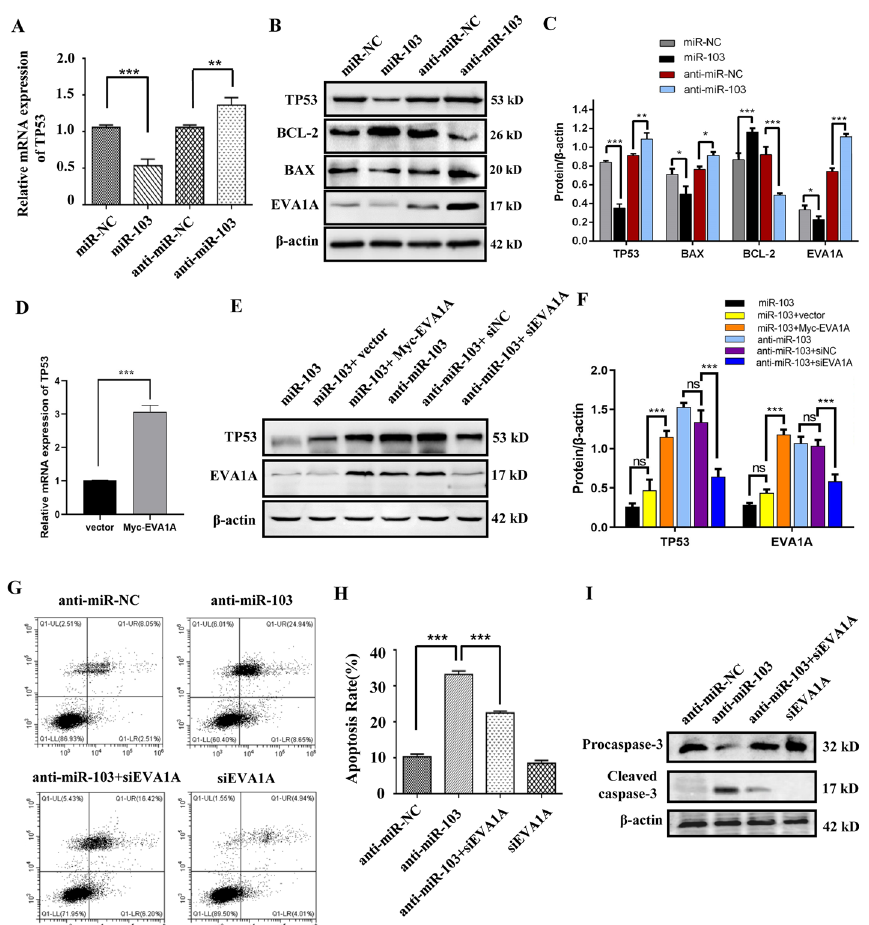
Fig. 7 Repression of miR-103a-3p induces HCC cells apoptosis through upregulating EVA1A/TP53 pathway. A Hccl-M3 cells were transfected with miR-103a-3p mimics, mimics control, miR-103a-3p inhibitor or inhibitor control. 72 h after transfection, the TP53 mRNA levels was detected by RT-qPCR. B The protein levels of TP53, BCL-2, BAX and EVA1A was detected by western blot. C Quantitative analysis of the blot bands of TP53, BCL-2, BAX and EVA1A. D RT-qPCR analysis of TP53 mRNA in Hccl-M3 cells overexpressing EVA1A. E Hccl-M3 cells were transfected with miR-103a-3p mimics alone or together with Myc-EVA1A plasmid, or transfected with miR-103a-3p inhibitors alone or together with siRNA of EVA1A.Then the expression of TP53 and EVA1A was detected by western blot. F Quantitative analysis of the blot bands of TP53 and EVA1A. G Hccl-M3 cells were transfected with miR-103a-3p inhibitor or siRNA of EVA1A, or both of them, then the apoptosis rate was assessed by Annexin V-FITC/PI staining and flow cytometry assay. H Statistical apoptosis rate of each group. Data are shown as means SD from three independent experiments. ** P < 0.01, *** P < 0.001. I Western blot ± analysis of caspase-3